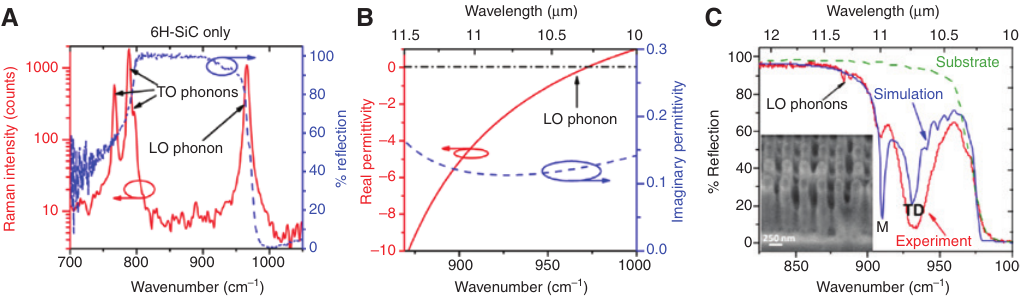
Figure 10: Generation of surface phonon polaritons. (A) Micro-Raman (red solid line) and Fourier transform IR (FTIR) reflection (blue dashed line) spectra of a 6H-SiC substrate, illustrating the role of LO and TO phonons in defining the highly reflective reststrahlen band. (B) Real and imaginary parts of the permittivity determined